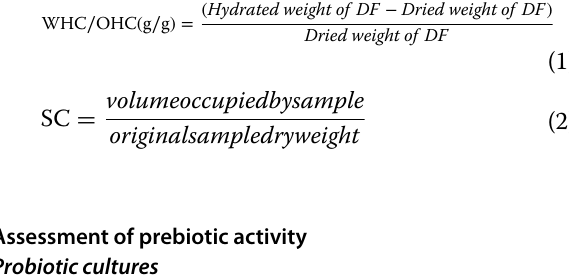
a-d Means with different superscripts within columns significantly differed ( P <0.05)